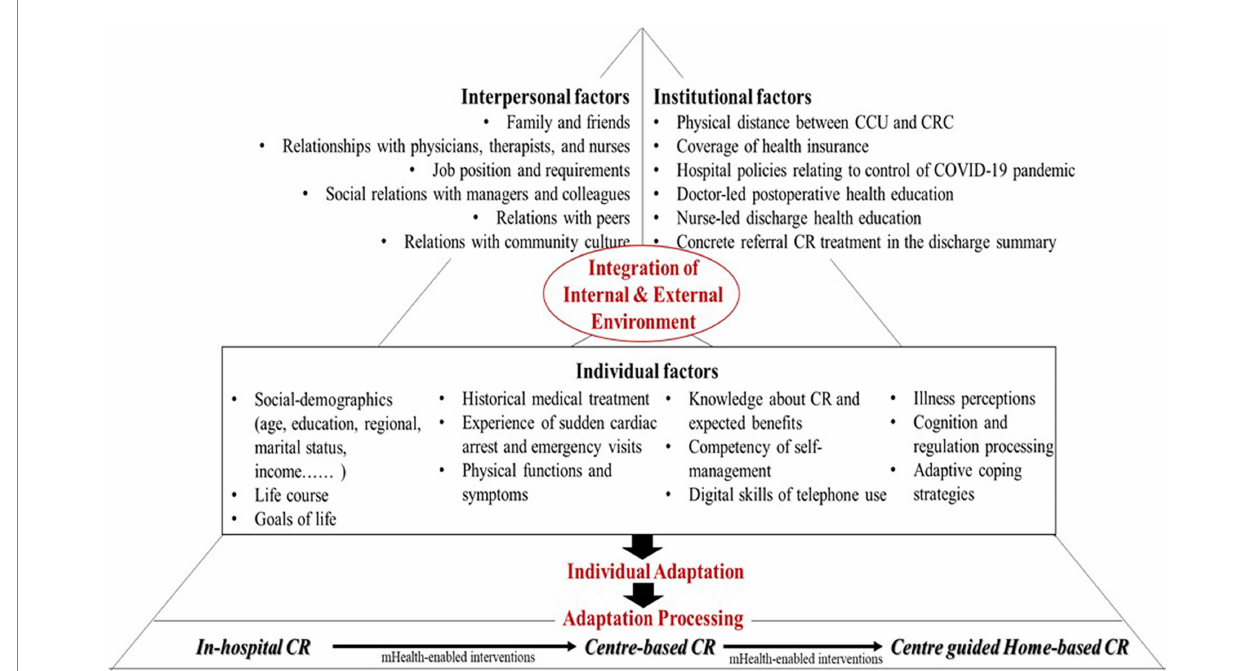
FIGURE 2 The logic model describing the institutional, interpersonal, and individual determinants for CR health behaviors.